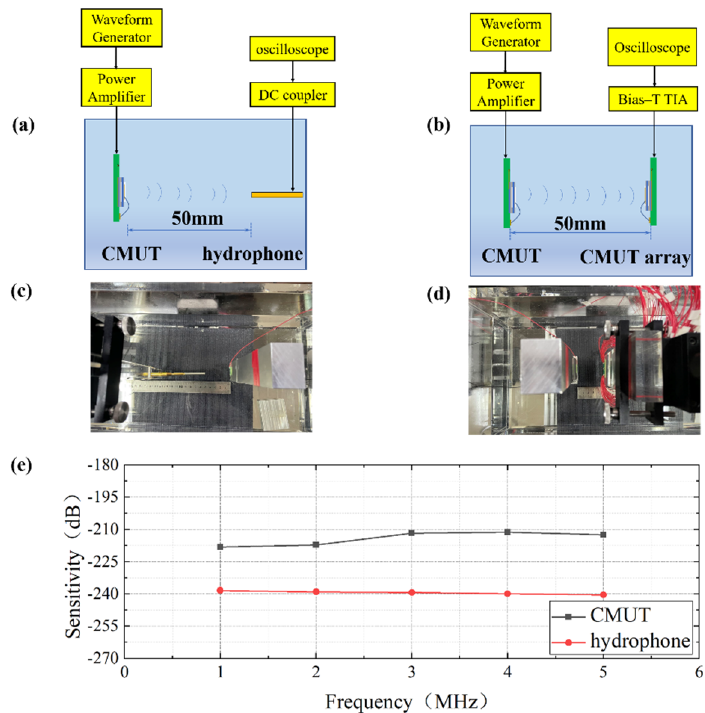
Figure 10. CMUT receiving sensitivity experiment. ( a ) CMUT transmitter with standard needle hydrophone receiver; ( b ) CMUT transmitter with CMUT array receiver; ( c , d ) Photos the experimental configurations; ( e ) Sensitivity curves of the CMUT array and the hydrophone.